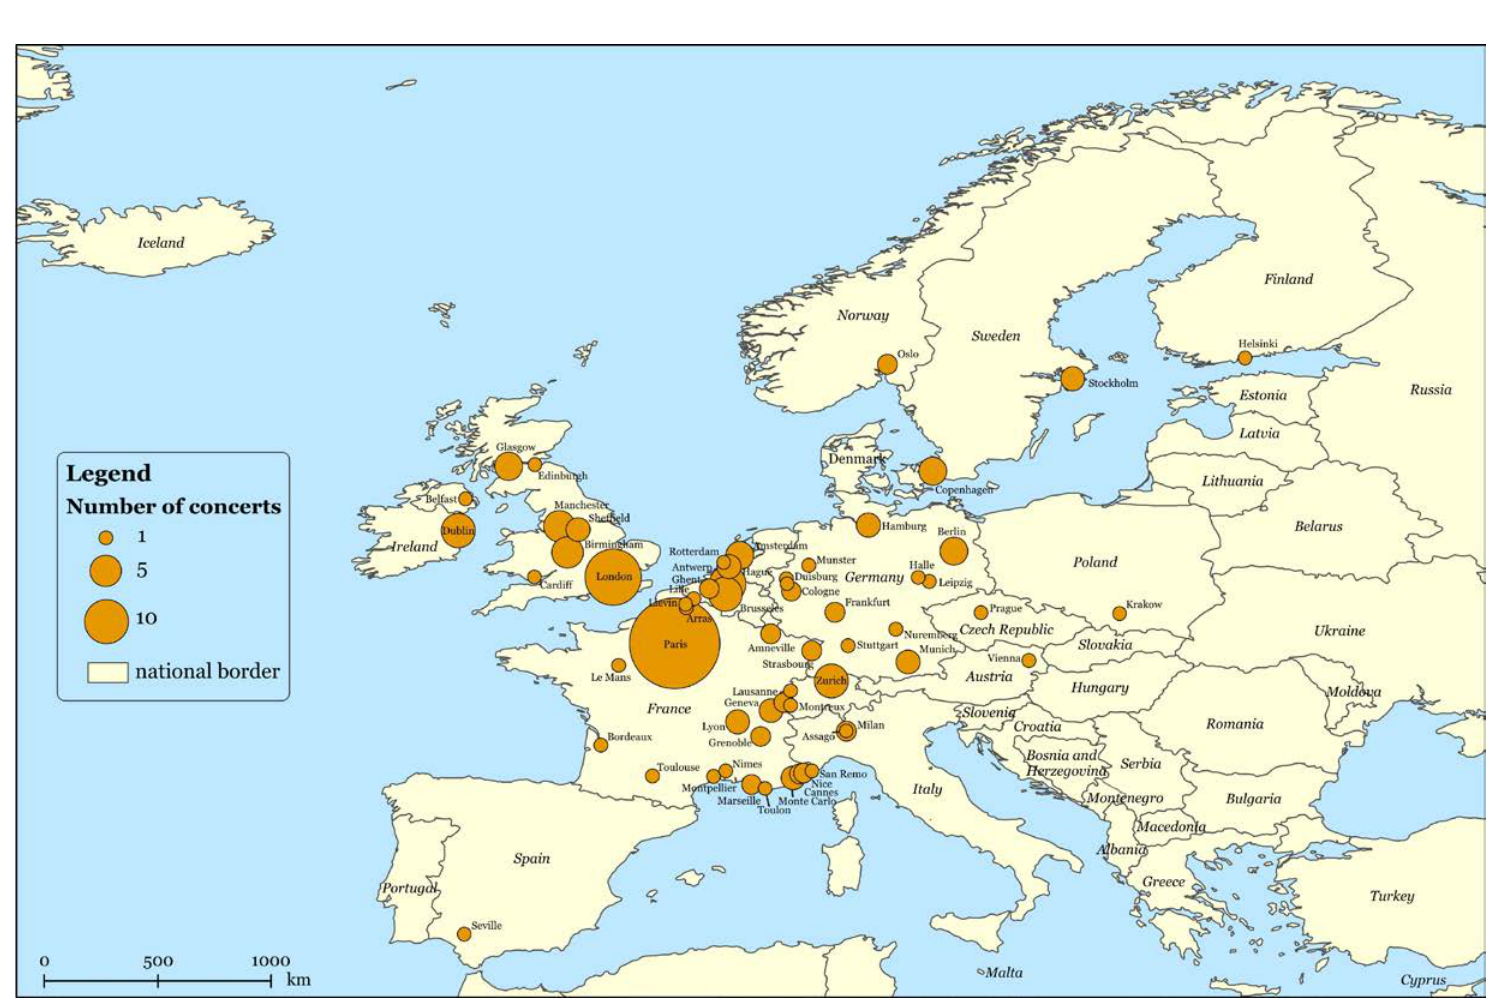
Figure 7: European cities as music scenes where Dion performed (1984 –